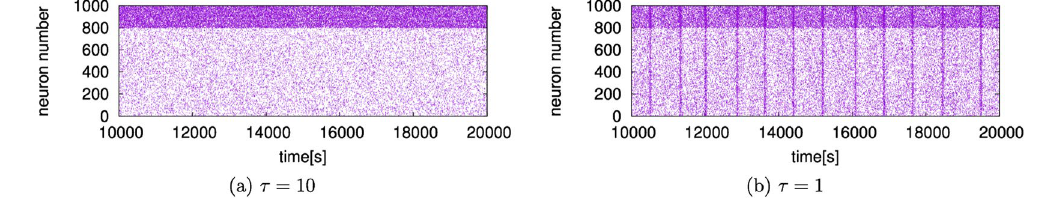
Figure 2. Raster plots when ( a ) τ = 10 [ms] and ( b ) τ = 1 [ms]. The horizontal axis is time [s]. The vertical axis is the neuron number: the numbers 1–800 correspond to excitatory neurons and the numbers 801–1000 correspond to inhibitory neurons.